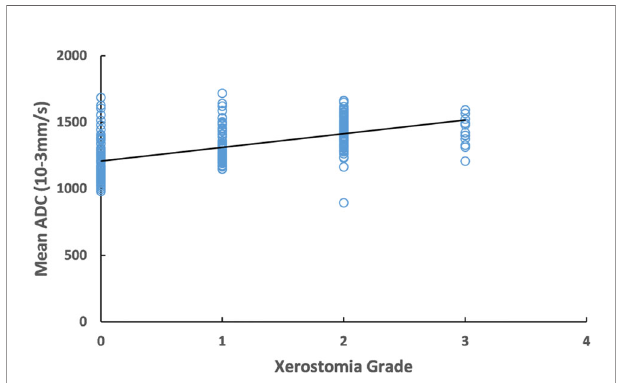
FIGURE 5 | Correlation between mean 3D-ADC values for the